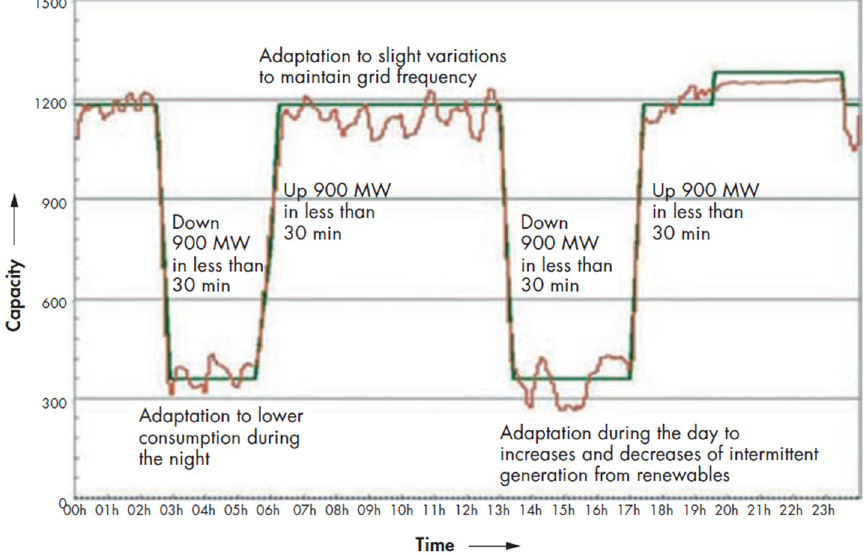
Figure 8. Power generated by a 1300 MW nuclear reactor over 24 h in response to grid variations.